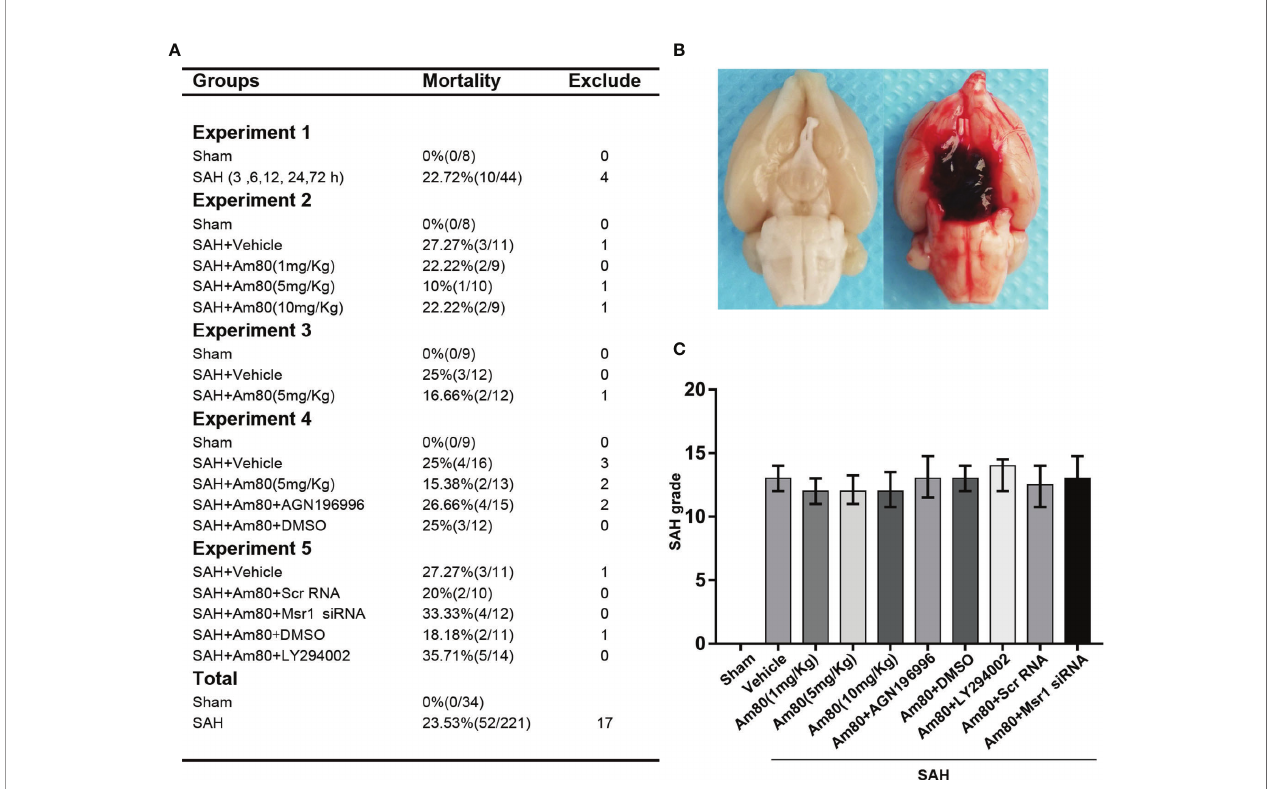
FIGURE 1 | Images of mortality, brain tissues and SAH grading in rats. (A) Animal usage and mortality. (B) Representative Image showing that blood clot in the subarachnoid space of the rat at 24 h after SAH. (C) SAH grading scores in each group. Error bars are represented as medians with interquartile range and analyzed by the Kruskal-Wallis test followed by Dunn ’ s post hoc